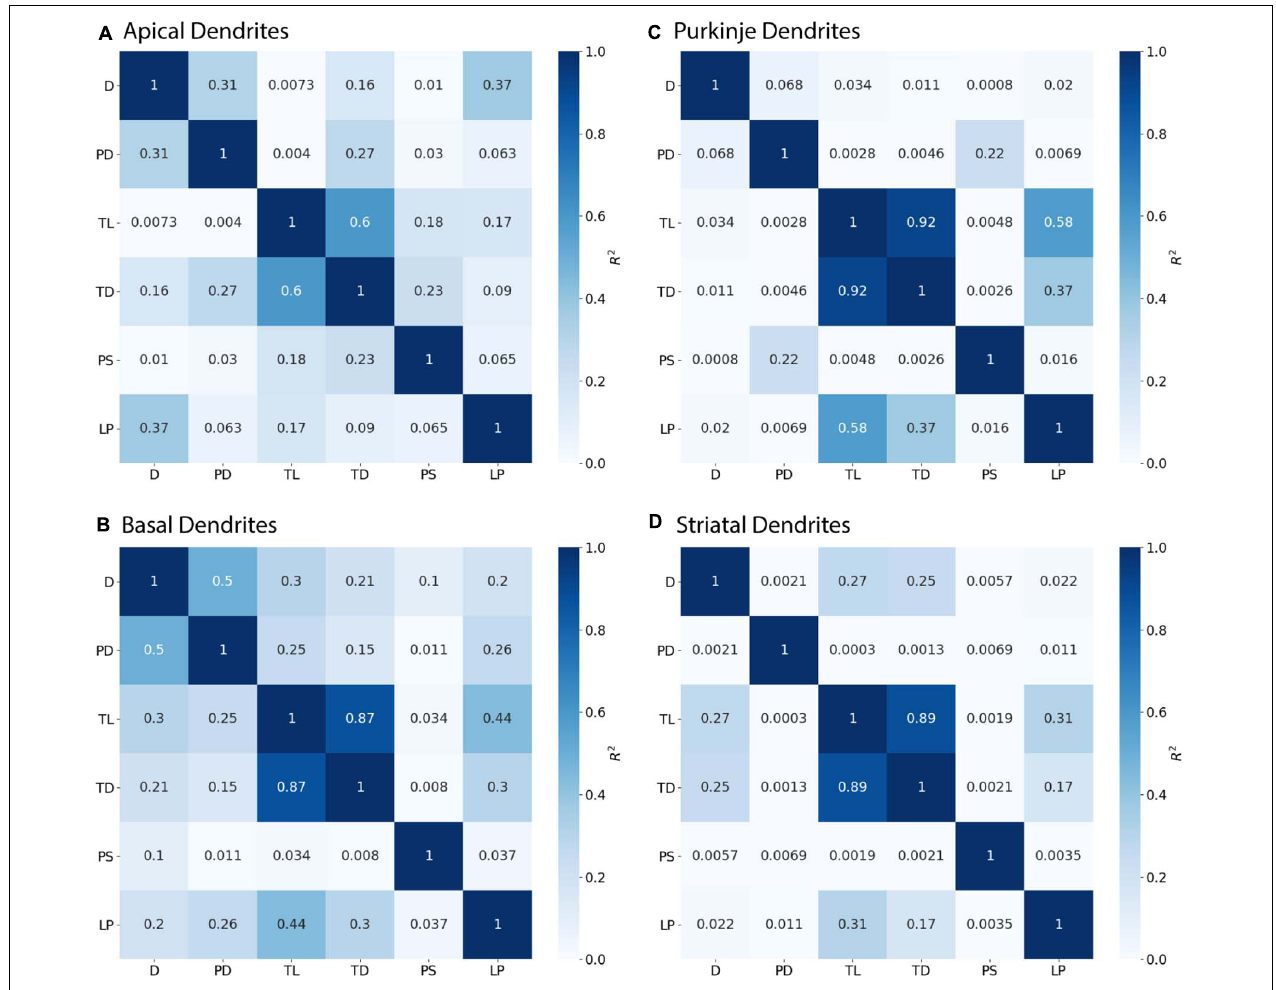
FIGURE 6 | Initial Nodes require multiple features to predict diameter. R 2 as Pearson’s coefficient of determination. (A–D) Diameter of initial nodes have moderate correlation with Parent Diameter (PD) for apical and basal dendrites of hippocampal pyramidal cells, and low correlation for cerebellar Purkinje cells and striatal SPNs. Stronger correlation to diameter for hippocampal dendrites was obtained by adding select features with PD. Diameter was correlated with Longest Path to Terminal End (LP) for apical dendrites of hippocampal pyramidal cells, and Path to Soma (PS) for basal dendrites of hippocampal pyramidal cells. Diameter was correlated with Total Dendritic Length (TL), but not PD, for striatal